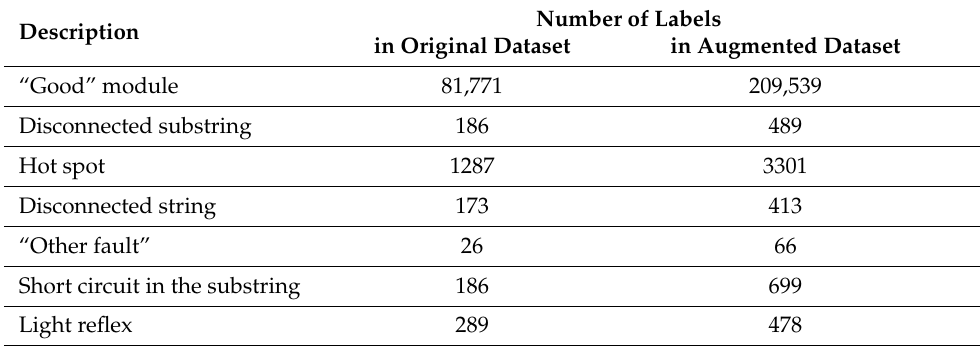
Table 4. Labels in the database used for experiments.